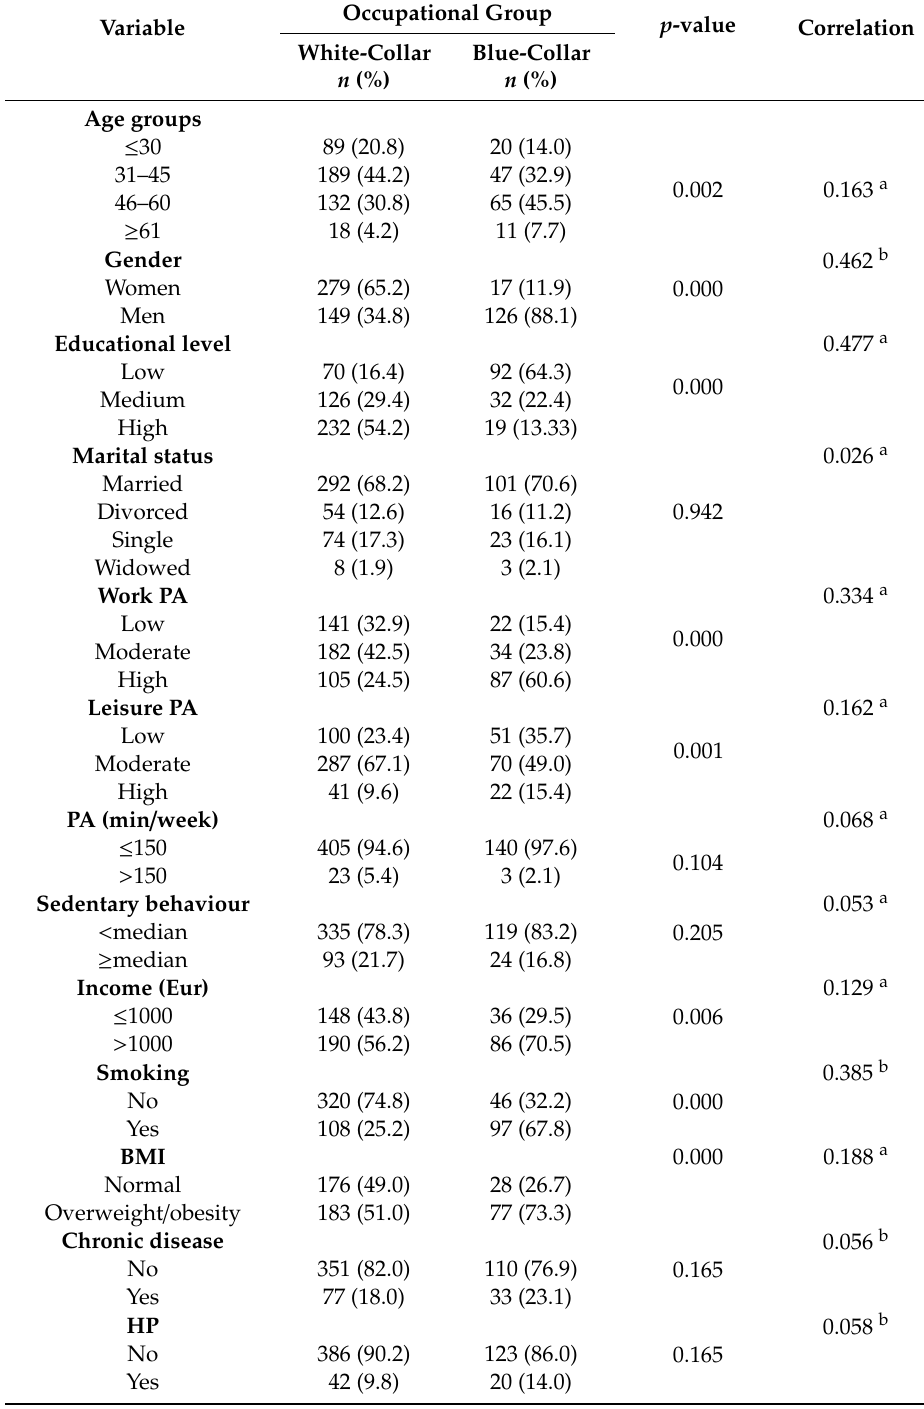
Table 1. The characteristics of study participants by occupational